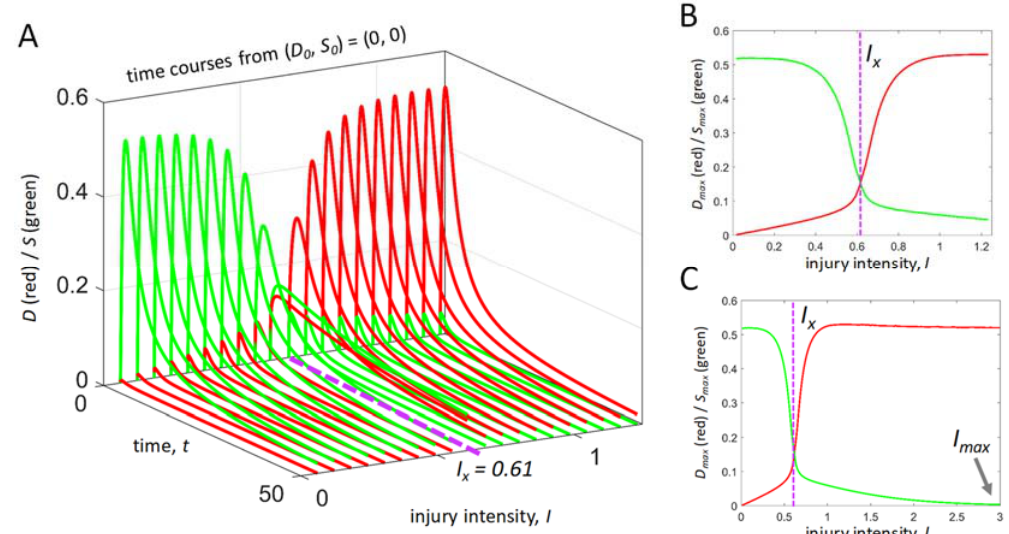
Figure 2. The injury course from initial conditions (0,0). ( A ) D and S time courses across the range 0 < I < 2 I X . ( B ) Plots of S max (green) and D max (red) vs. I , for the time courses shown in A. ( C ) Plots of S max and D max vs. I across the range 0 < I < 5 I X illustrating I max . Purple dashed lines indicate the position of I X on the injury course.